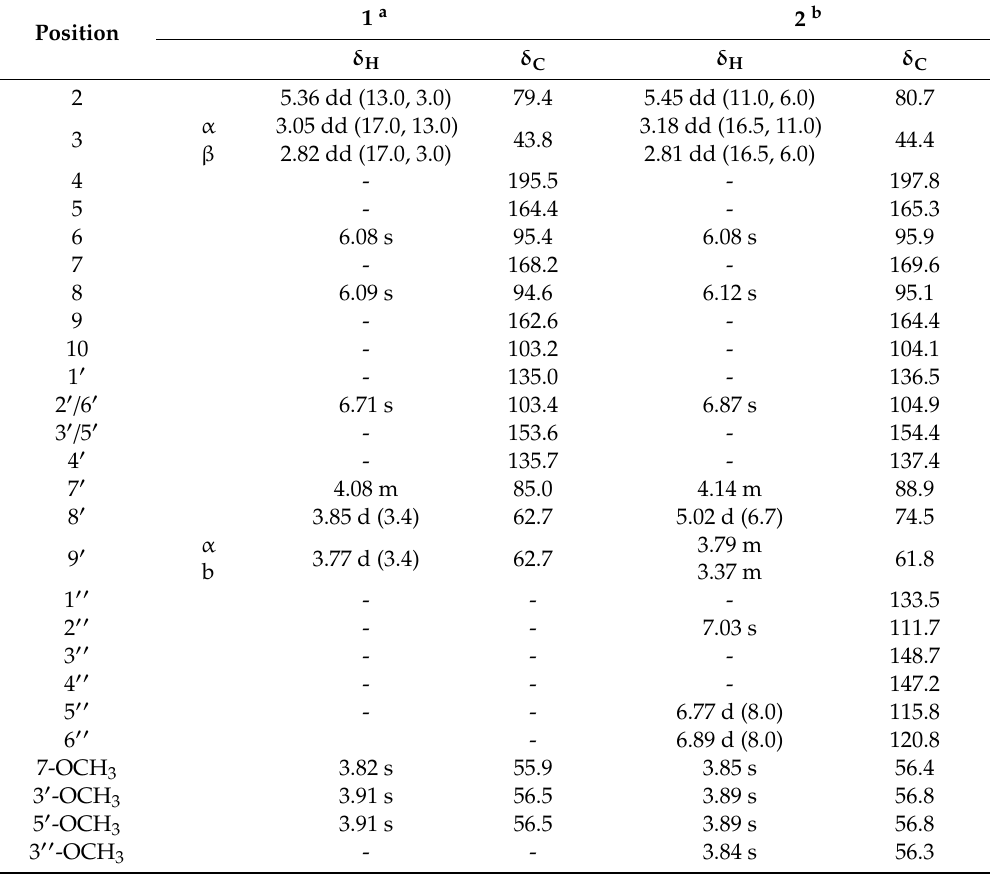
Table 1. 1 H- and 13 C-NMR data of 1 and 2 ( δ in ppm, J in Hz).